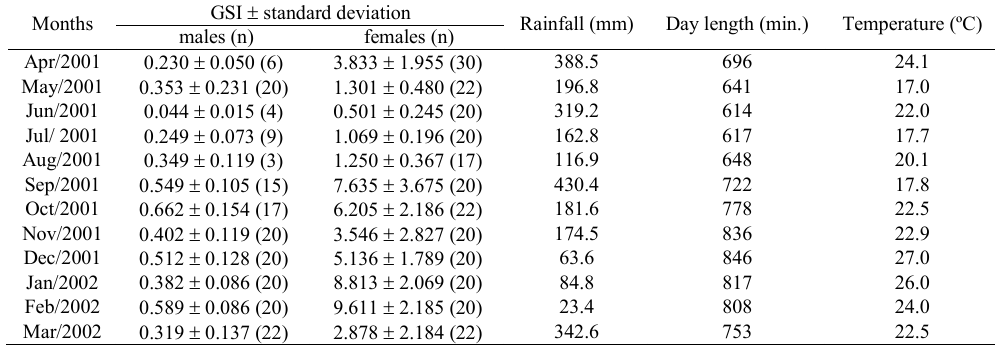
Table 2. Monthly variation of the means of the gonadossomatic index (GSI) (± standard deviation) for males and females of